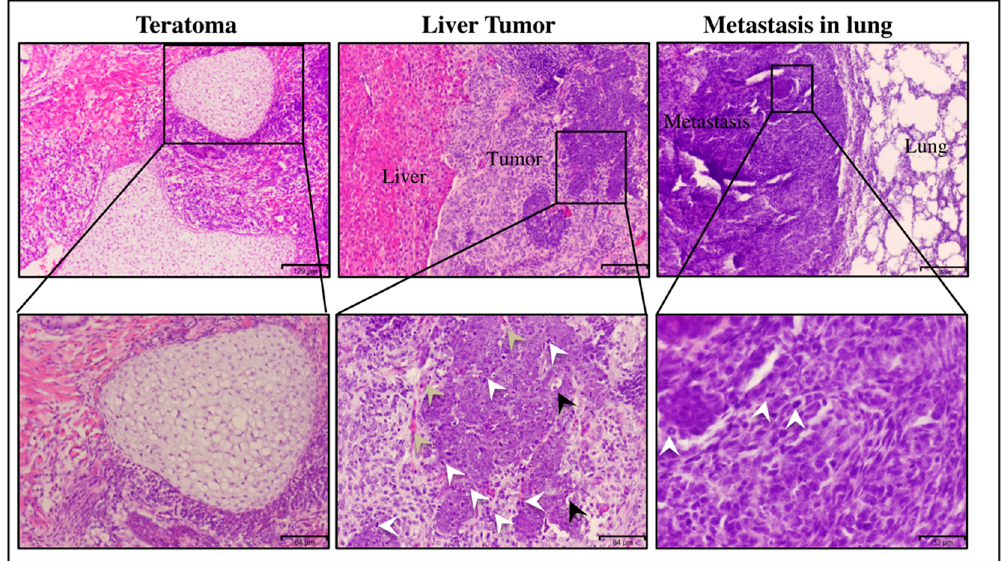
Figure 2. Histopathological analysis of representative hematoxylin–eosin-stained sections of malignant tumor in the liver (scale bars represent 129 μ m), which showed abnormal mitotic figures (white arrow), cellular infiltration of blood vessels (bale yellow arrow), cytoplasmic degeneration (black arrow) and high nuclear-to-cytoplasmic ratio. Scale bars represent 64 μ m. The lung metastatic nodules show the mitotic figures (white arrow), (scale bars represent 32 μ m) and tumor derived from miPS, which showed teratoma phenotype (scale bars represent 129 μ m).